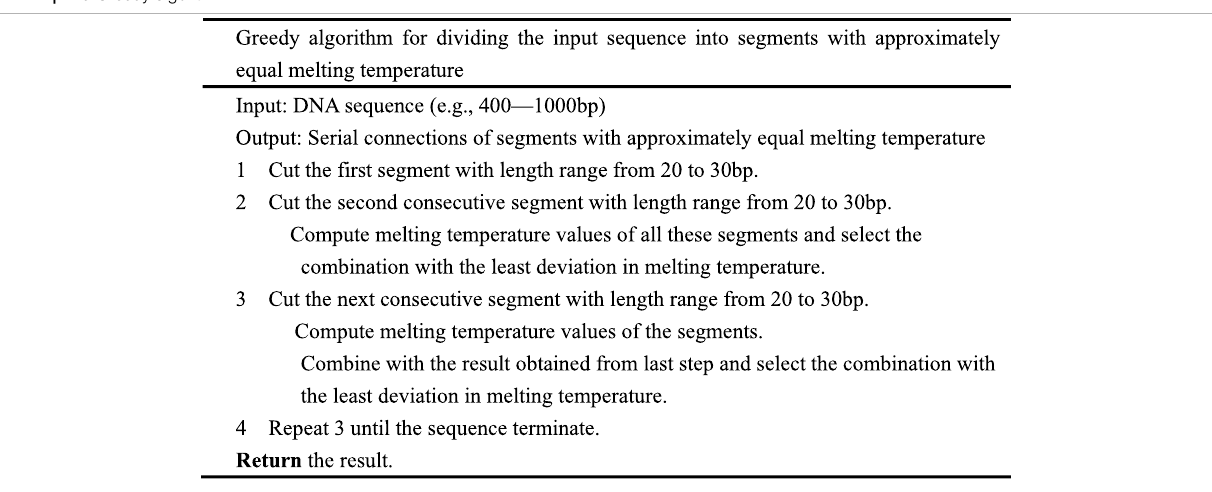
TABLE 1 | The Greedy